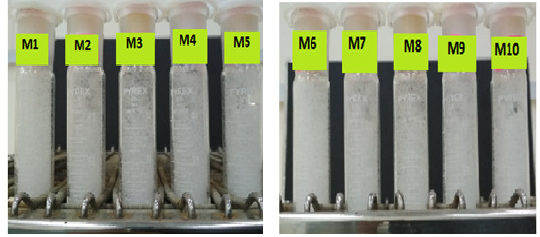
FIG. 1. FOAM GENERATED BY SURFACTANT